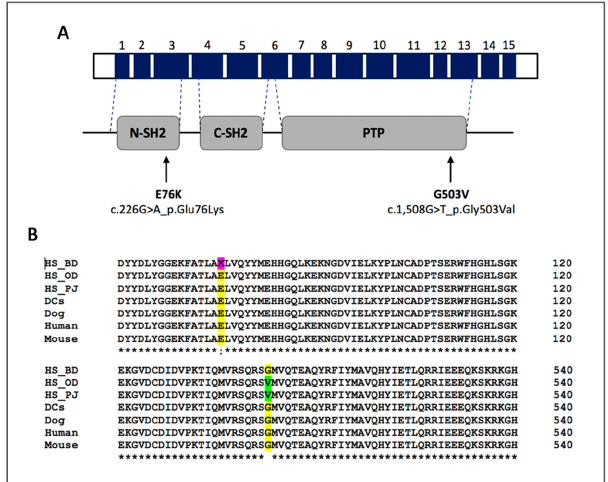
Figure 1. Sites of PTPN11 mutations. ( A ) Schematic representation of PTPN11 gene product with corresponding functional domains of SHP-2, indicating the locations of E76K and G503V mutations, with the predicted amino acid changes. Top bar is a schematic representation of the genomic structure with numbered exons (dark blue), and the lower bar depicts the functional domains. ( B ) Alignment of SHP-2 protein sequences from histiocytic sarcoma (HS) cell lines (BD, OD and PJ), normal canine dendritic cells (DCs), and reference sequences from relevant species (Dog, Human and Mouse). Missense mutations identified in canine HS, highlighted in pink (E76K) and green (G503V), are located within the highly conserved regions shown in yellow. Protein sequences were aligned using Clustal Omega software